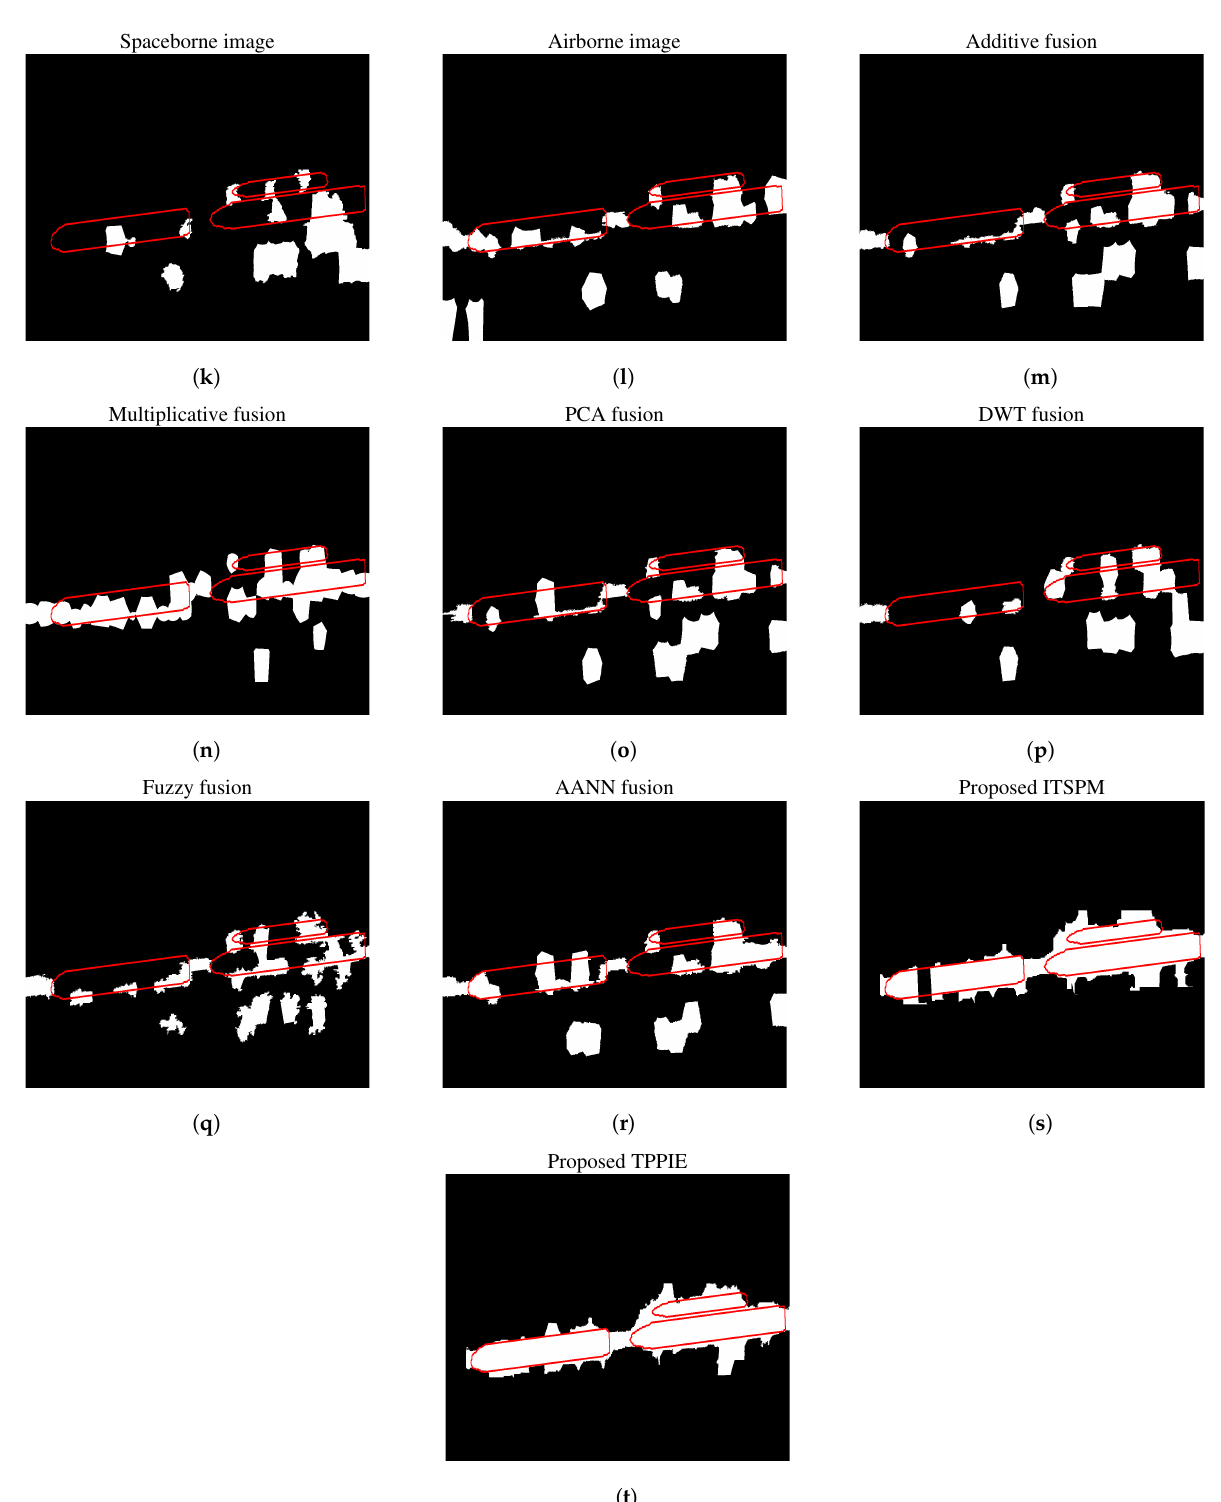
Figure 10. Superpixel-based detection results of different methods for Experimental Scene 2 with respect to PFA = 0.05: ( a ) Spaceborne image processing (PD = 0.2009); ( b ) airborne image processing (PD = 0.3922); ( c ) additive fusion [10] (PD = 0.3181); ( d ) multiplicative fusion [10] (PD = 0.6167); ( e ) PCA fusion [12] (PD = 0.3478); ( f ) DWT fusion [13] (PD = 0.2762); ( g ) fuzzy fusion [16] (PD = 0.3261); ( h ) AANN fusion [18] (PD = 0.4741); ( i ) proposed ITSPM fusion (PD = 0.9492); and ( j ) proposed TPPIE fusion (PD = 0.9909 ). The red lines denote the boundaries of target vessels. The proposed TPPIE fusion method had the best detection